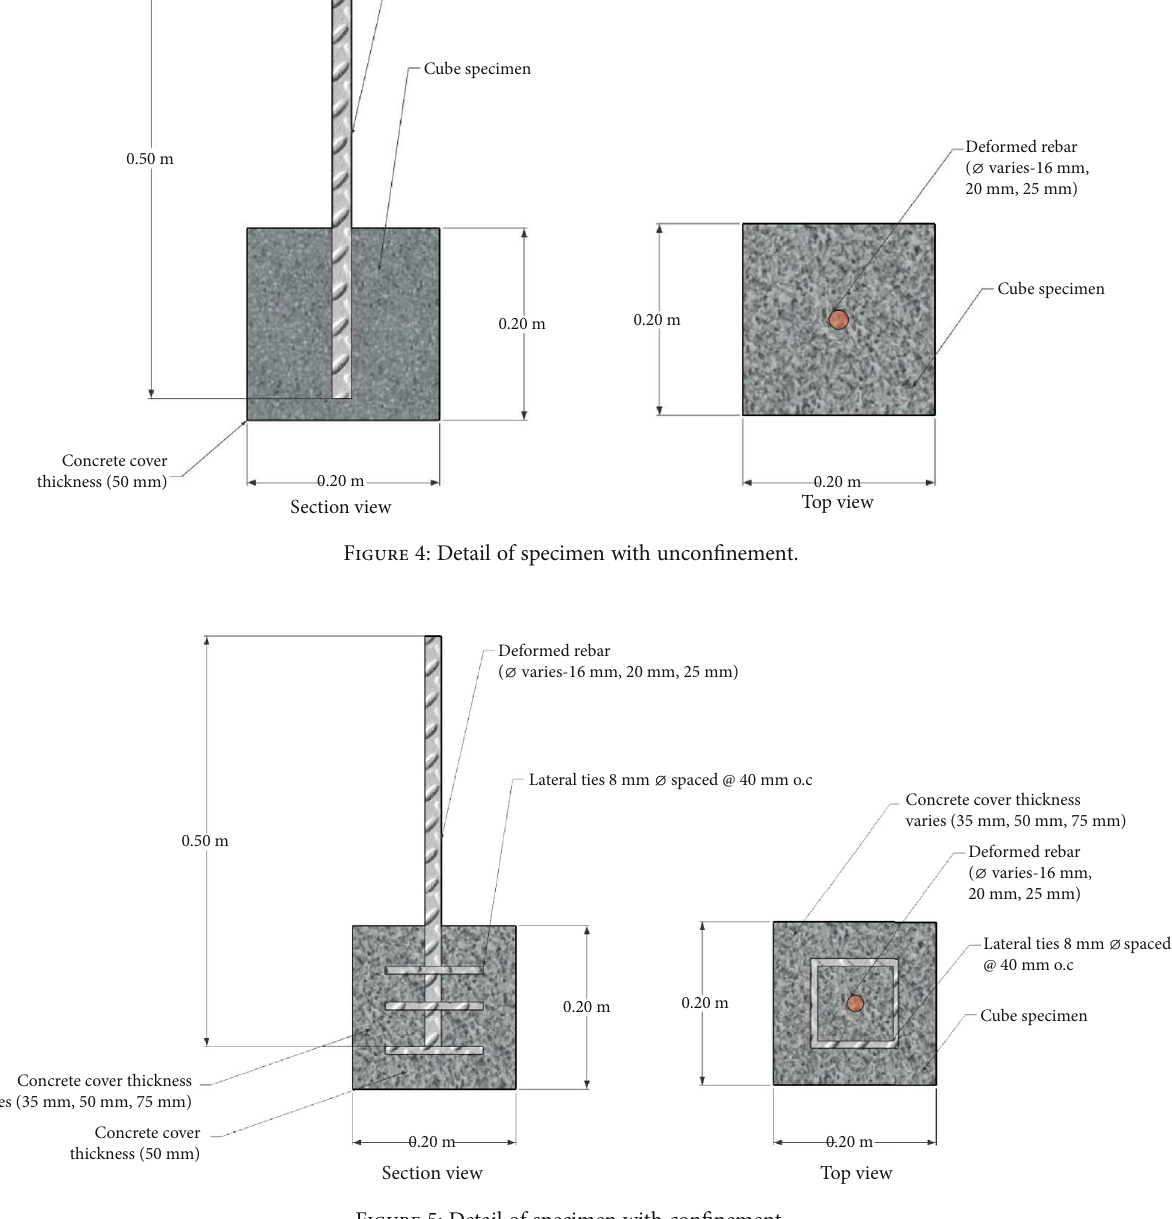
Figure 5: Detail of specimen with con fi